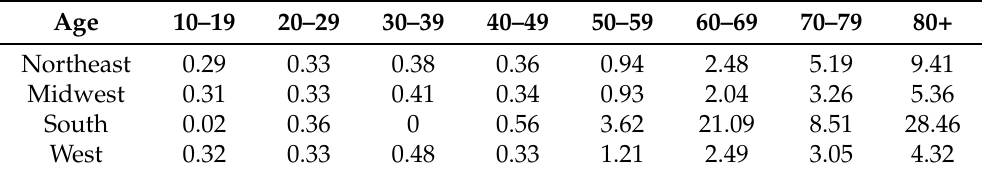
Table 8. Neural network-estimated probabilities of death for a white male with no pre-existing conditions by region and age group. Given as percentages.